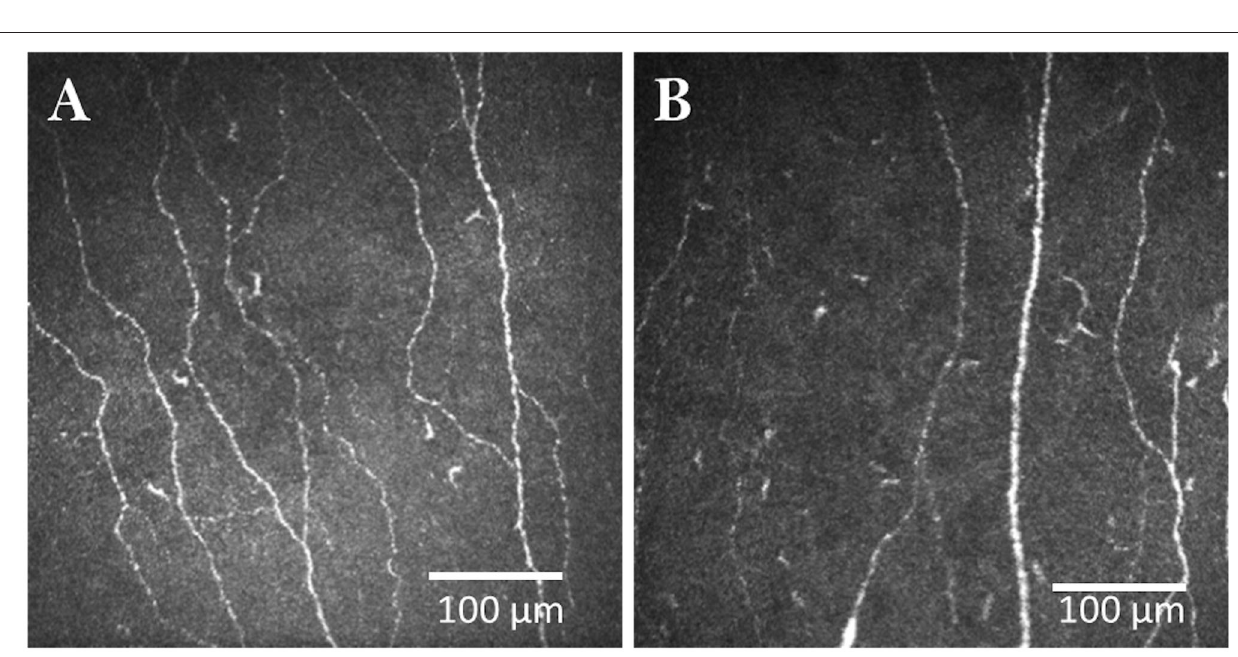
FIGURE 4 | CCM images of the central cornea in a healthy control (A) and patient with Parkinson’s disease (B)